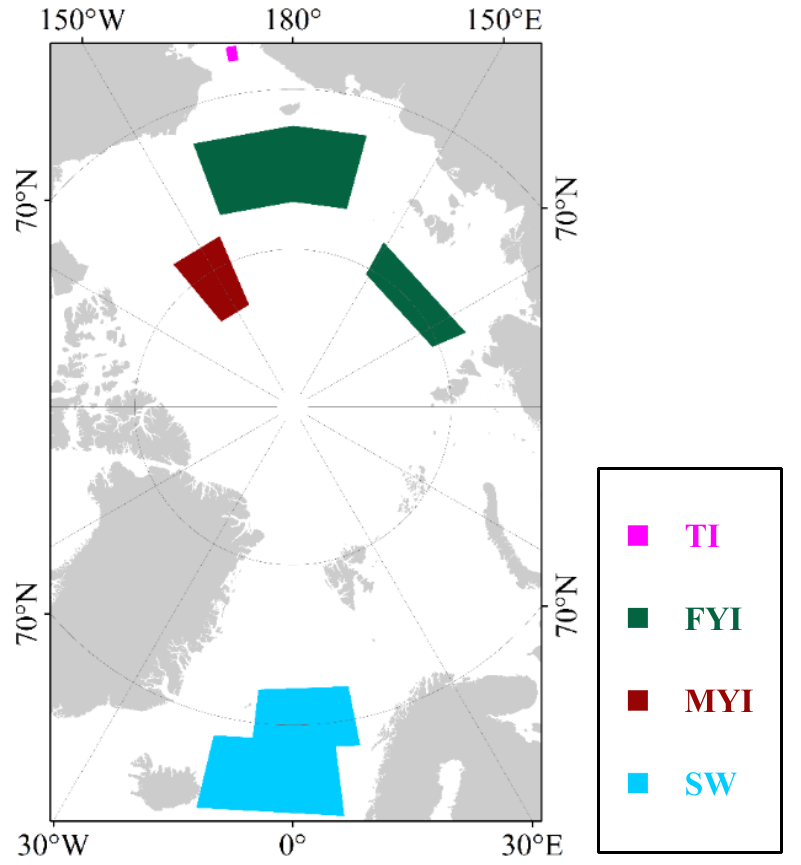
Figure 13. Invariant regions of the categories from 5–28 January 2020. Table 9. Overall accuracies and F1 scores of the top multifeature combinations based on continuous- date data of invariable